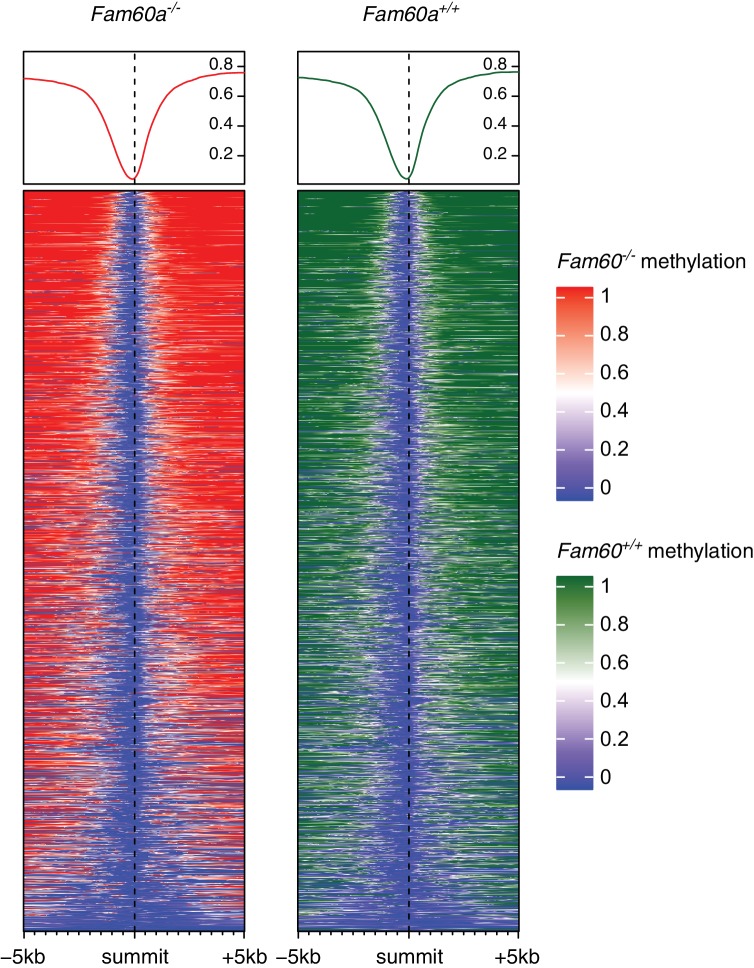
Heatmaps with DNA methylation levels over Fam60a-bound promoters.A methylation profile of Fam60a-bound promoter regions is shown for wild-type and Fam60a-/- embryos. A Fam60a-bound promoter region was defined as a 10 kb region between 5 kb upstream and 5 kb downstream of a Fam60a ChIP-seq peak summit. For the methylation value of each CpG, the mean of triplicates was used. The heatmap was plotted by EnrichedHeatmap (Gu et al., 2018) of Bioconductor package with following parameters: bin size = 50 bp, mean mode = absolute, and smoothing = on. The center of the heatmap indicates the peak summits of Fam60a-bound regions obtained from the ChIP-seq experiments. Regions containing hypomethylated CpGs are shown in blue. The line plots above the heatmap summarizes the enrichment of DNA methylation. Note that most of Fam60a-bound promoter regions are hypomethylated, and there is no obvious difference in the heatmap between wild-type and Fam60a-/- embryos.